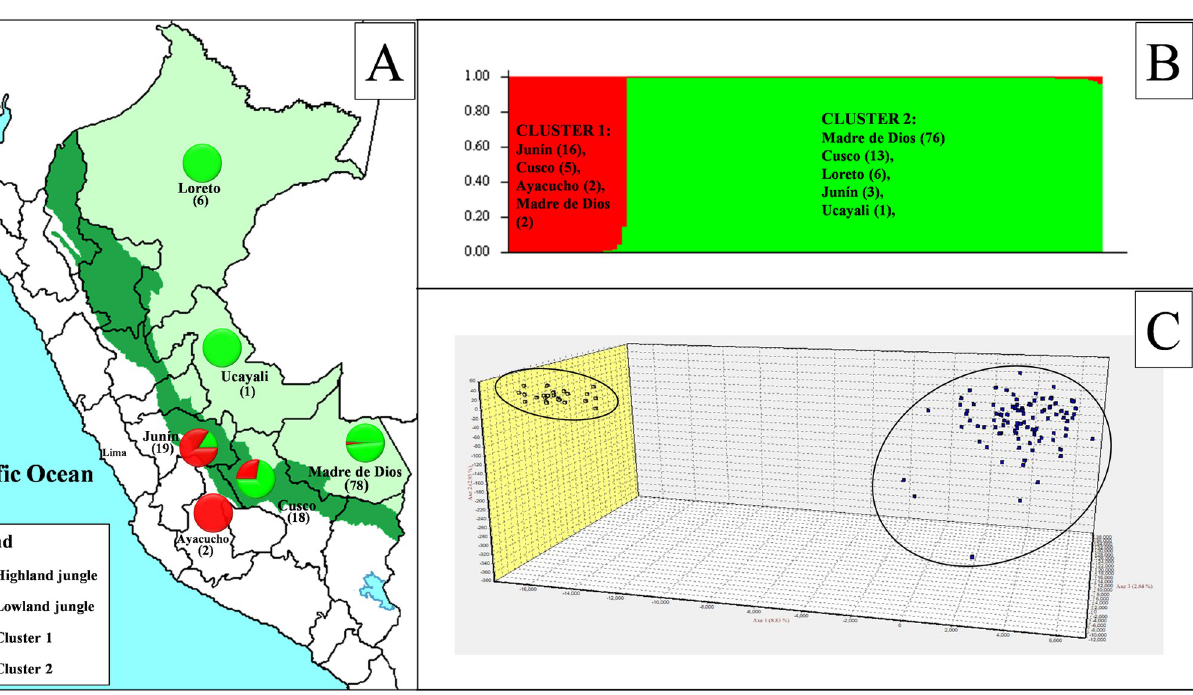
Given the different sample sizes between clusters, the allelic richness analysis after the rare- faction method was based on a sample size of 21 diploid individuals per cluster, which was the smallest number of individuals to be analyzed (Table 5).